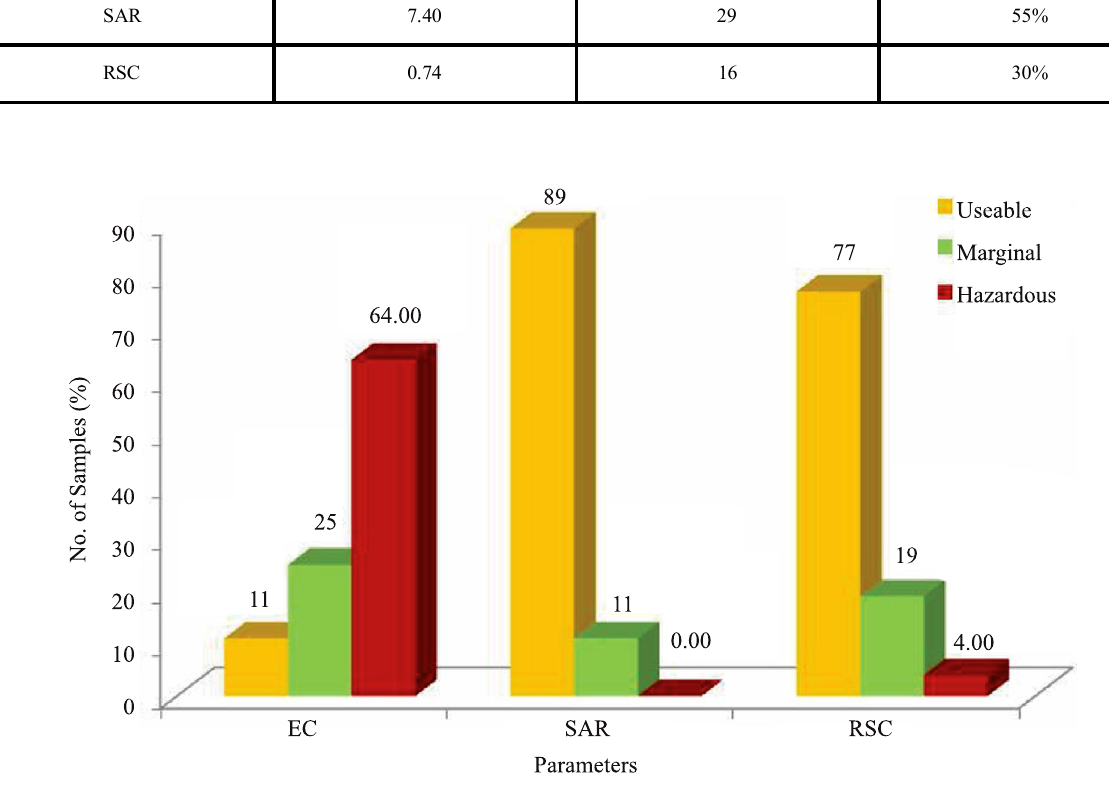
FIG 1. GROUNDWATER QUALITY OF TALUKA MITHI AND ISLAMKOT ON THE BASIS OF EC, SAR AND RSC